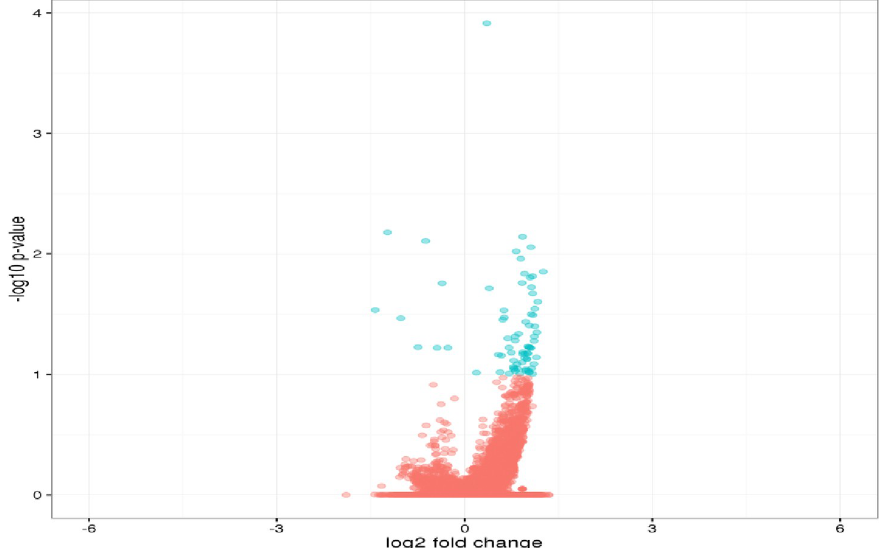
Fig 5. Volcano plot of expressed transcripts as determined by RSEM/EBseq. Blue dots indicate significantly higher expressed genes in pansteatitis as compared to healthy adipose tissues. Blue dots to the right side of zero on the x axis indicate the upregulated genes while those on the right show the downregulated genes.